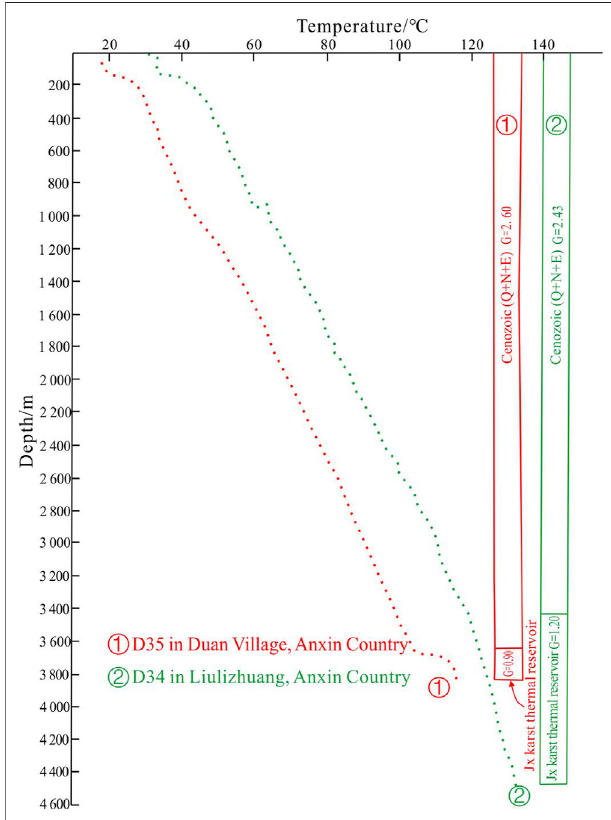
FIGURE 5 | Temperature measurement curve of D34 and D35 (G = gradient; ° C/100 m).